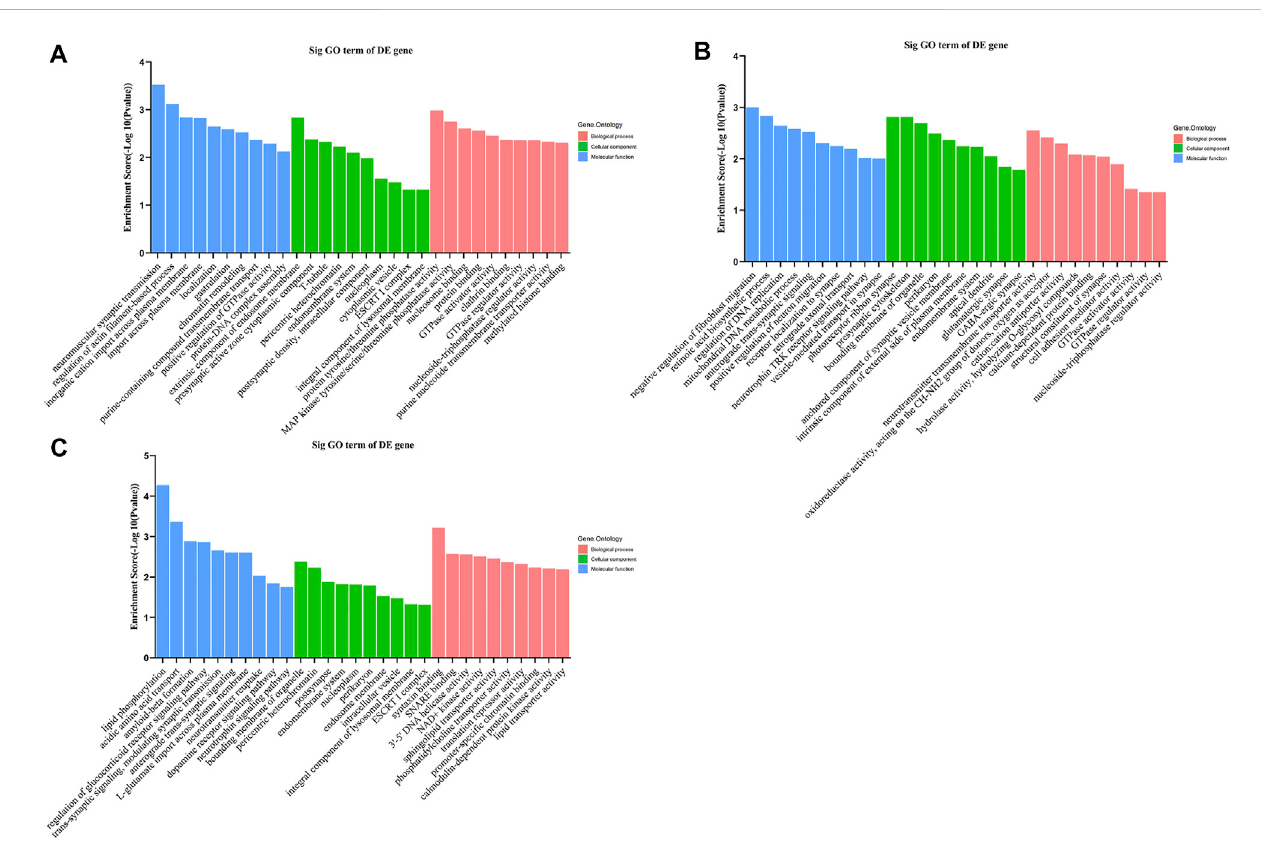
Gene Ontology enrichment analysis shows the 10 related functions changed signi fi cantly after methamphetamine self-administration. Gene Ontology enrichment analysis for potential target genes of (A) tiRNA-1-34-Lys-CTT-1, (B) tRF-1-16-Ala-TGC-4 and (C) tRF-1-32-Gly-GCC-2-M2. The horizontal axis showsthebiologicalprocess(redbars),cellularcomponent(greenbars)andmolecularfunction(bluebars)terms,vertical axisshowstheenrichmentscoreof each term. GO: Gene Ontology, DE: differently expressed.